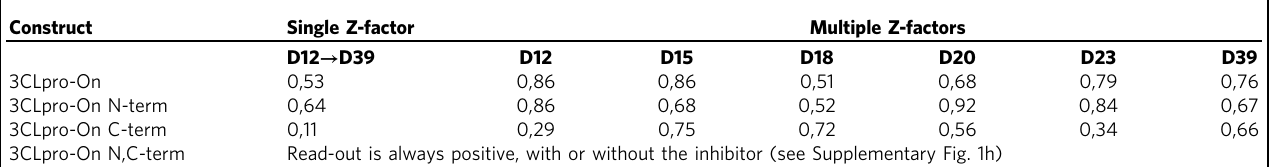
Table 3 Z-factor values, divided in differentiated (multiple Z-factors) and non-differentiated (single Z-factor) according to the day of read-out (D12 →